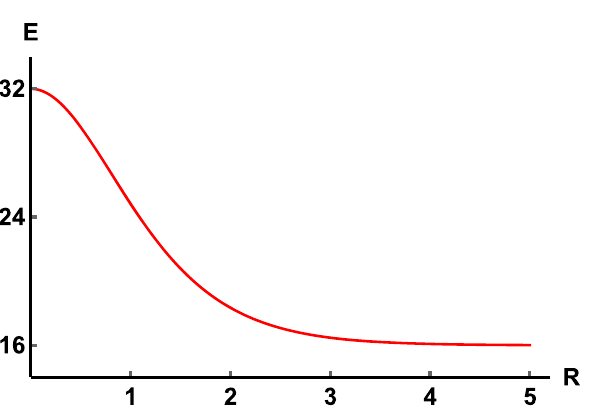
Fig. 2 Kinks and antikinks (21) for n = 0 and various R ’s